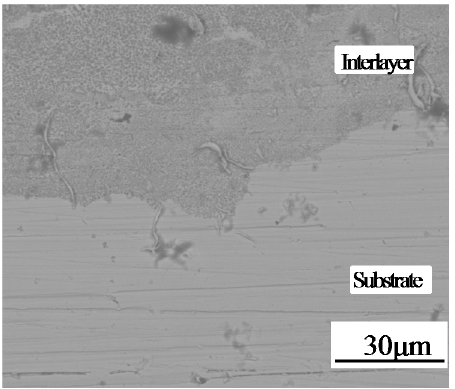
Figure 5. Microstructure of the interface between the interlayer and substrate.